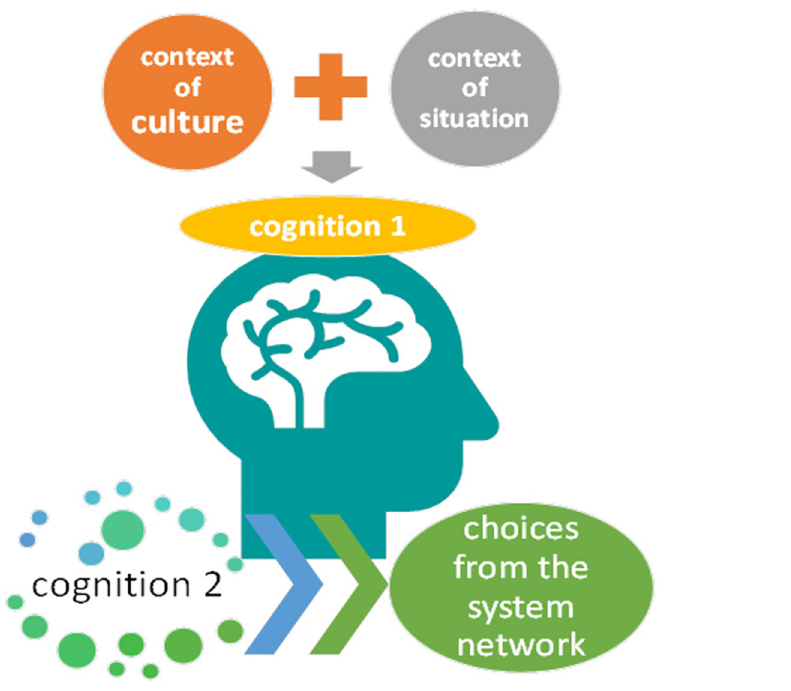
Fig 12. Model flow of pragmatics defined in the theoretical framework of